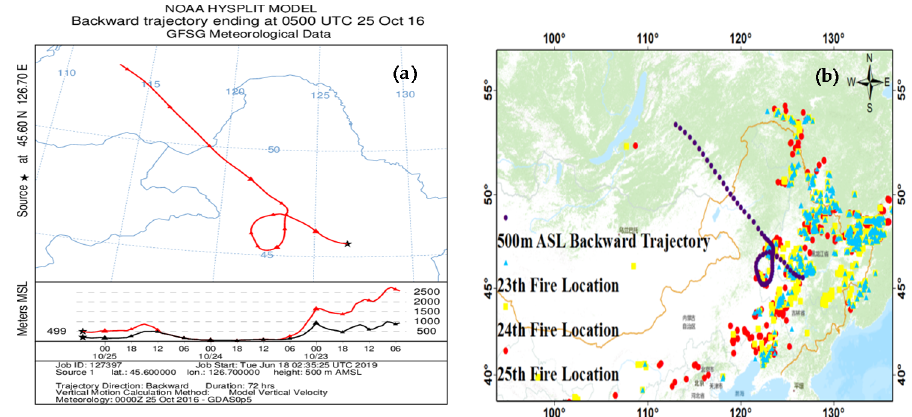
Figure 6. The 72 ‐ h backward trajectory and satellite fire spots. ( a ) Horizontal and vertical section of the 72 ‐ h backward trajectory (black line represents the topography); ( b ) combined view of the 72 ‐ h backward trajectory and three ‐ day satellite fire spots from 23 October to 25 October.